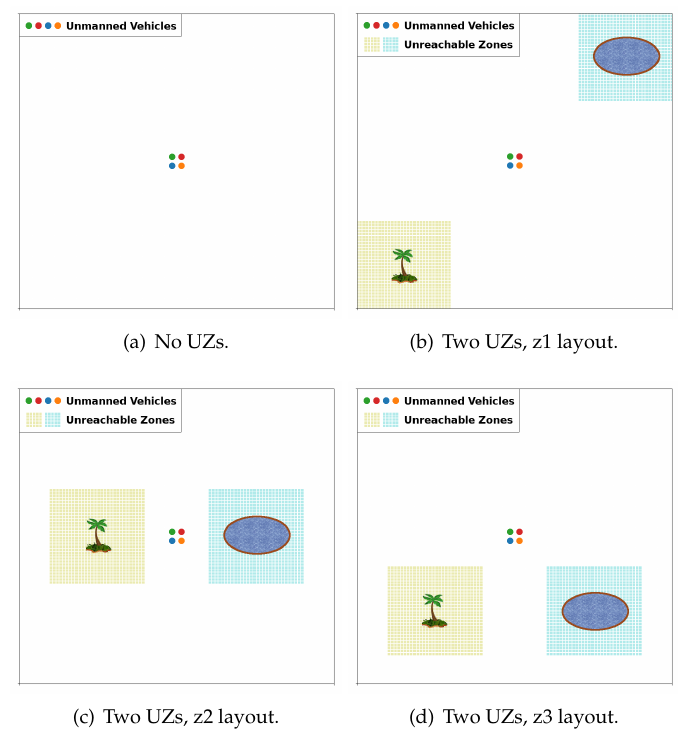
Figure 4. Case studies without ( a ) and with square unreachable zones ( b – d ). In these examples, there are four vehicles placed at their starting position in the centre of the